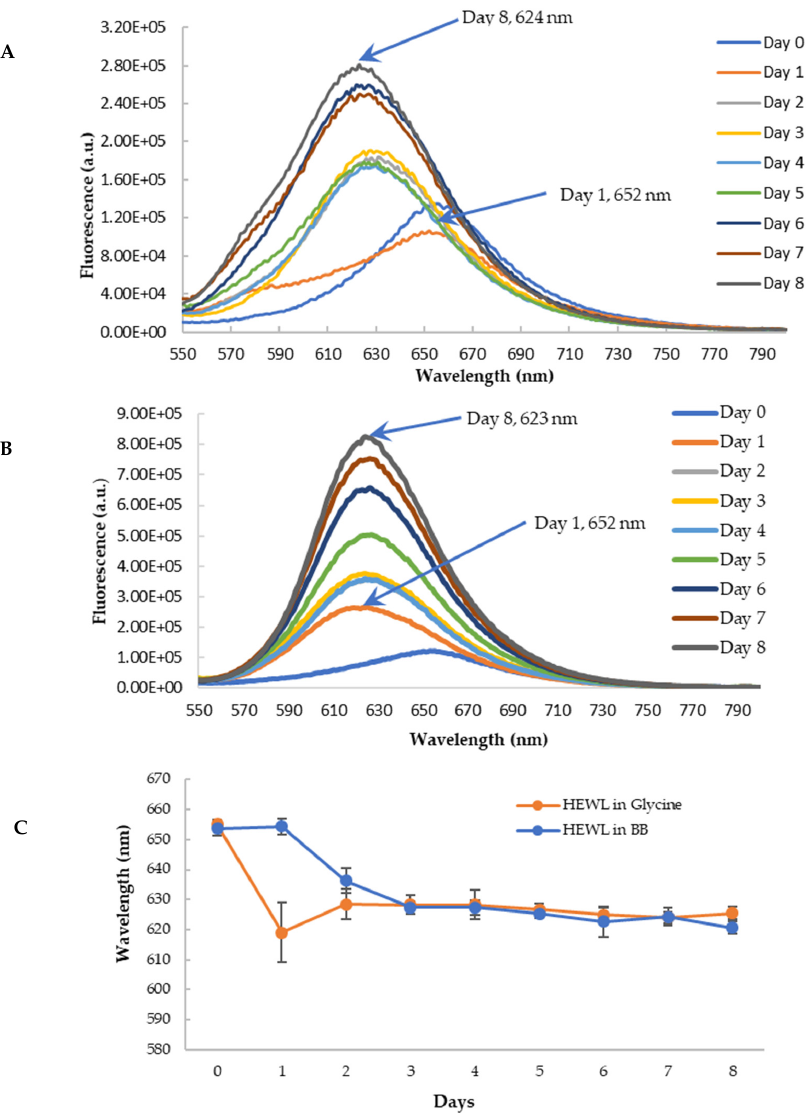
Figure 9. Fluorescence emission spectra of Nile Red with HEWL in glycine buffer with excitation at 530 nm. ( A ): HEWL alone; ( B ): Blueberry-treated HEWL; ( C ): The maximum emission wavelength of HEWL alone (orange) and blueberry-treated HEWL (blue). The error bars represent the SD with three independent runs.